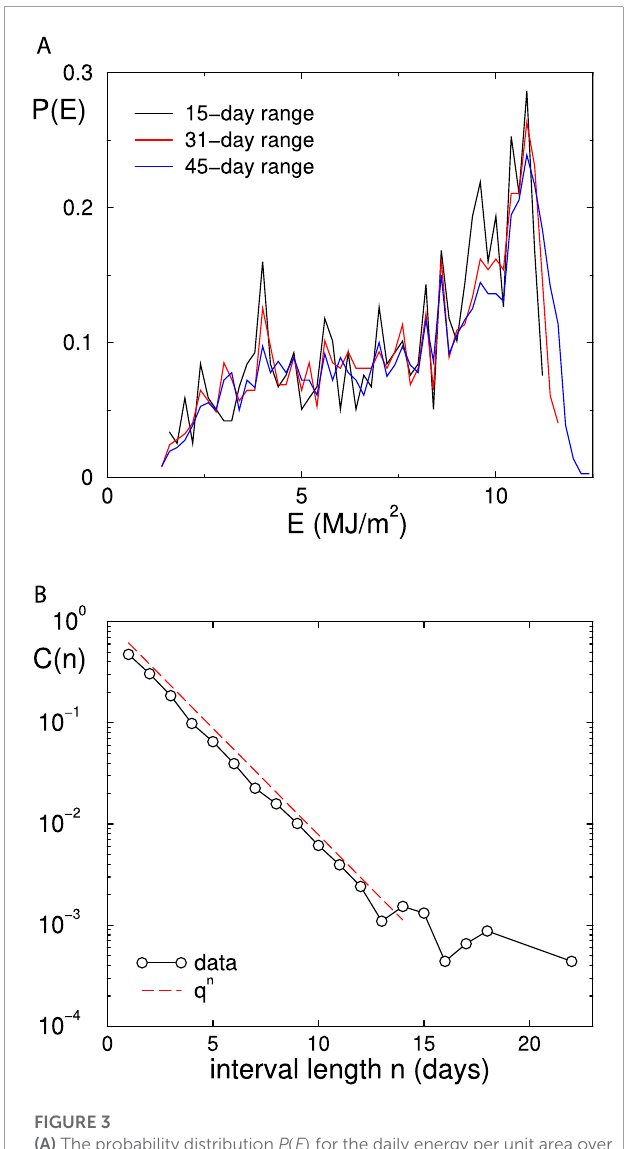
FIGURE 3 (A) The probability distribution P ( E ) for the daily energy per unit area over symmetric time intervals around the minimum-energy day (day 357). (B) Probability C ( n ) that the ratios r j ≡ E j /⟨ E j ⟩ are all greater than or all less than 1 over n consecutive days. Also shown is the exponential best fit to the data in the range n ≤ 13, C ( n ) ∝ q n , with q = 0 . 6157.